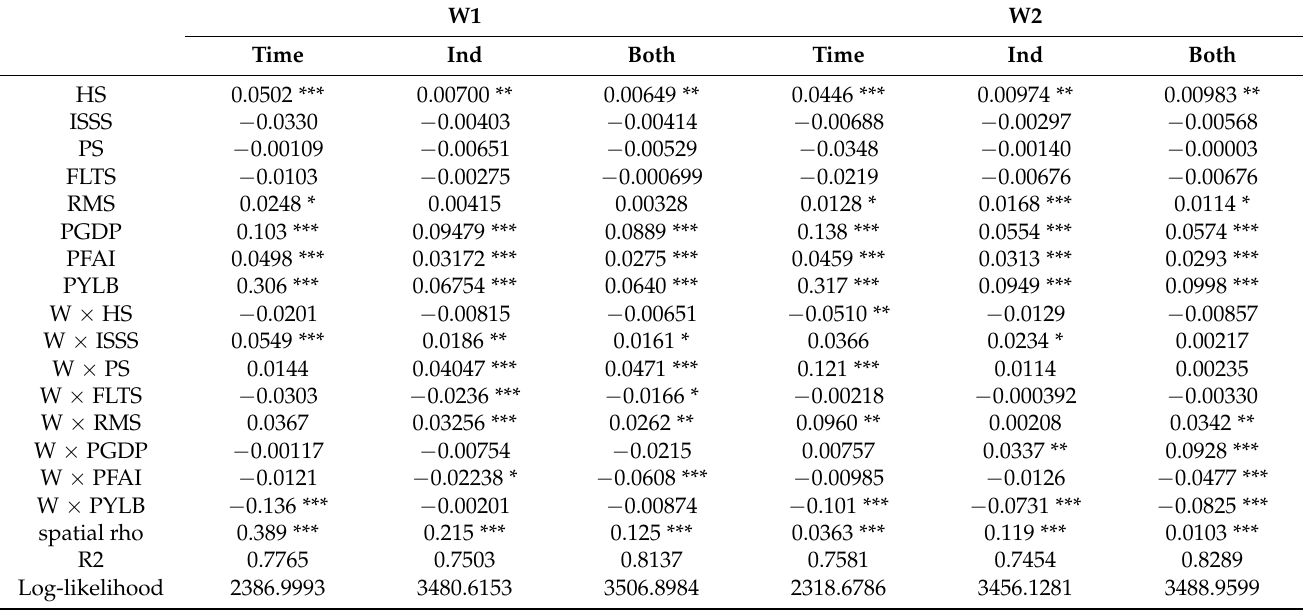
Table 8. Estimation results of SDM.